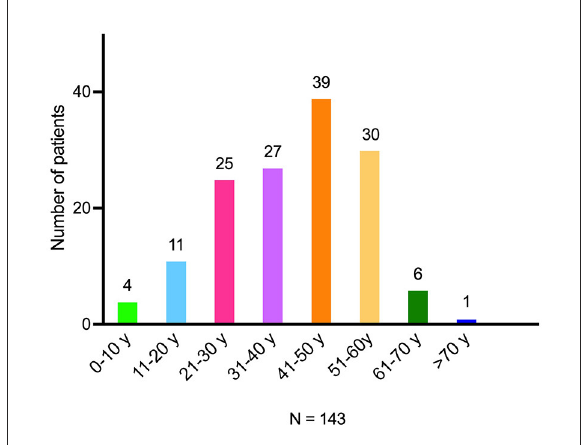
FIGURE1 Age at disease onset for NMOSD. NMOSD indicates neuromyelitis optica spectrum disorder.